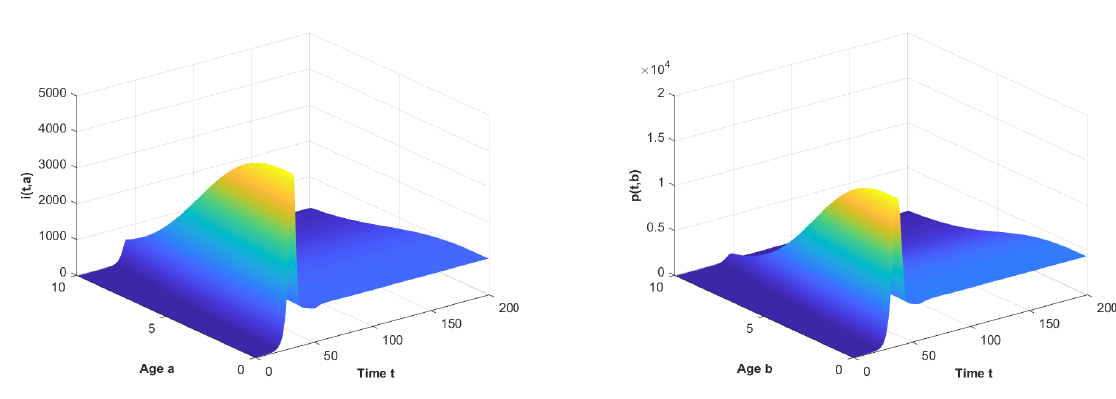
Figure 1. The long-term dynamical behavior of i ( t , a ) and p ( t , b ) as q = 10 − 4 .